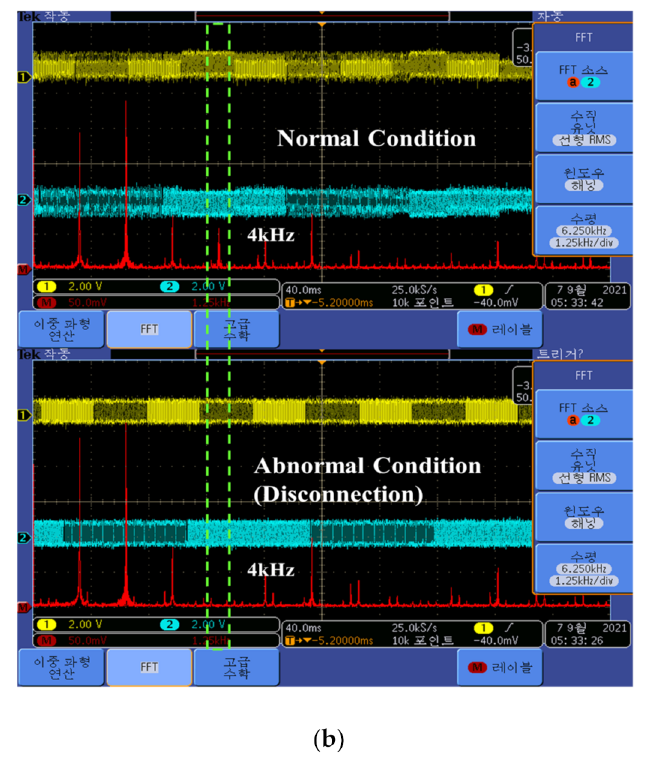
Figure 27. Frequency and FFT characteristics according to the PV system’s operational status: ( a ) high side; ( b ) low side.